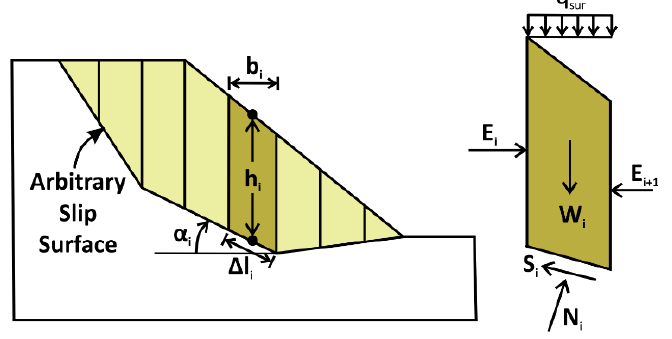
Figure 7. Noncircular slip surface and forces in Janbu’s simplified method.